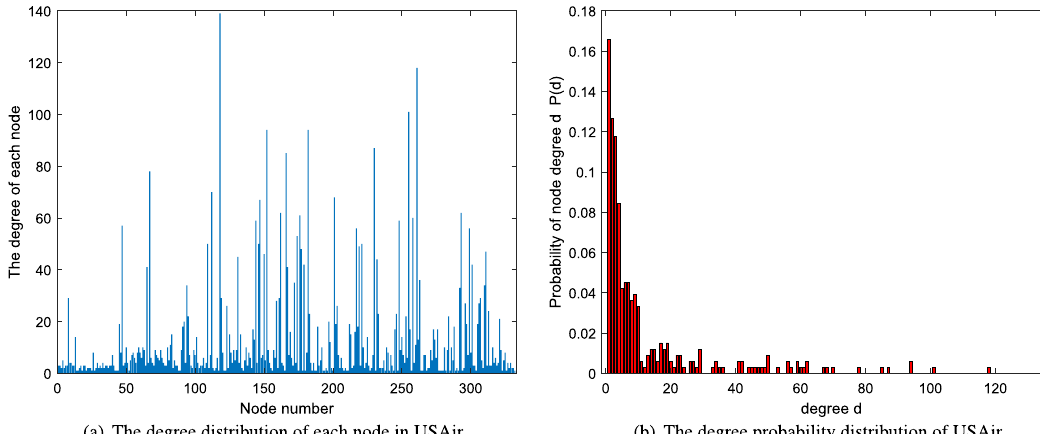
Figure 5. The degree distribution of network USAir.